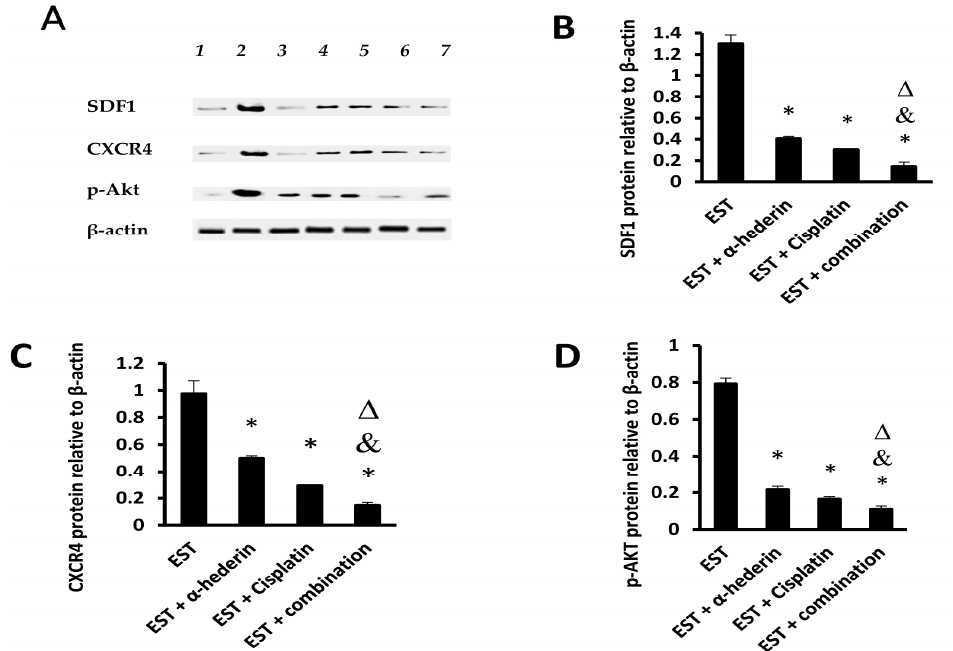
Figure 3. Western blotting for the target proteins. Panel ( A ): gels for the (1,3) EST + combination group; (2) EST control group, (4,5) EST + α‐ hederin group, (6,7) EST + cisplatin group. Panel ( B ): Column chart for SDF1 Panel ( C ): column chart for CXCR4 and Panel ( D ): column chart for p ‐ AKT. *: versus EST control, &: versus EST + α‐ hederin group, Δ : versus EST + cisplatin group. Data are mean ± SD and statistically analyzed at p < 0.05.